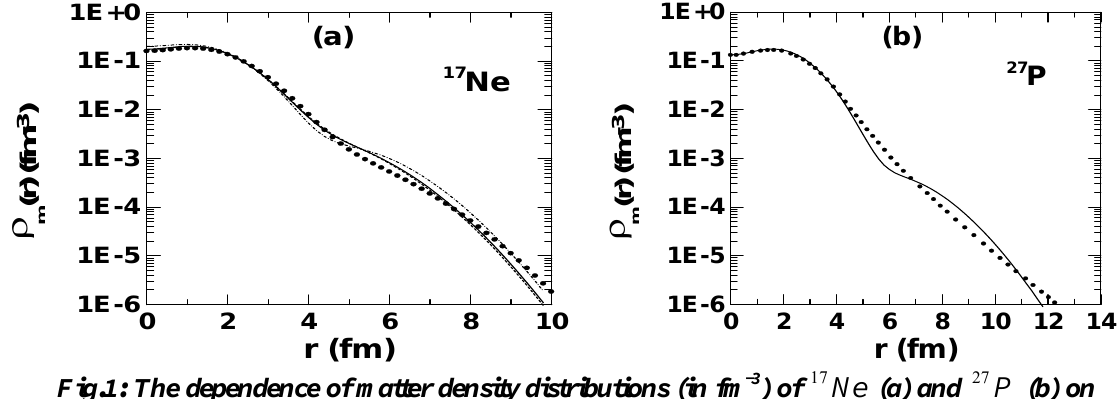
Fig.1: The dependence of matter density distributions (in fm -3 ) of r (in fm). In (a), the solid line corresponds to the density calculated when the outer two protons in Ne 17 move within the  sd model space, the dashed and dash-dotted lines 1 d and correspond to densities calculated when the outer two protons move in the pure 2/5 s respectively. In (b), the solid line corresponds to the density calculated when pure ,2 2/1 s The filled circles in (a) and (b) the outer proton in P 27 moves in the pure .2 2/1 correspond to experimental densities deduced from Glauber model by Refs. [23] and [41], respectively.